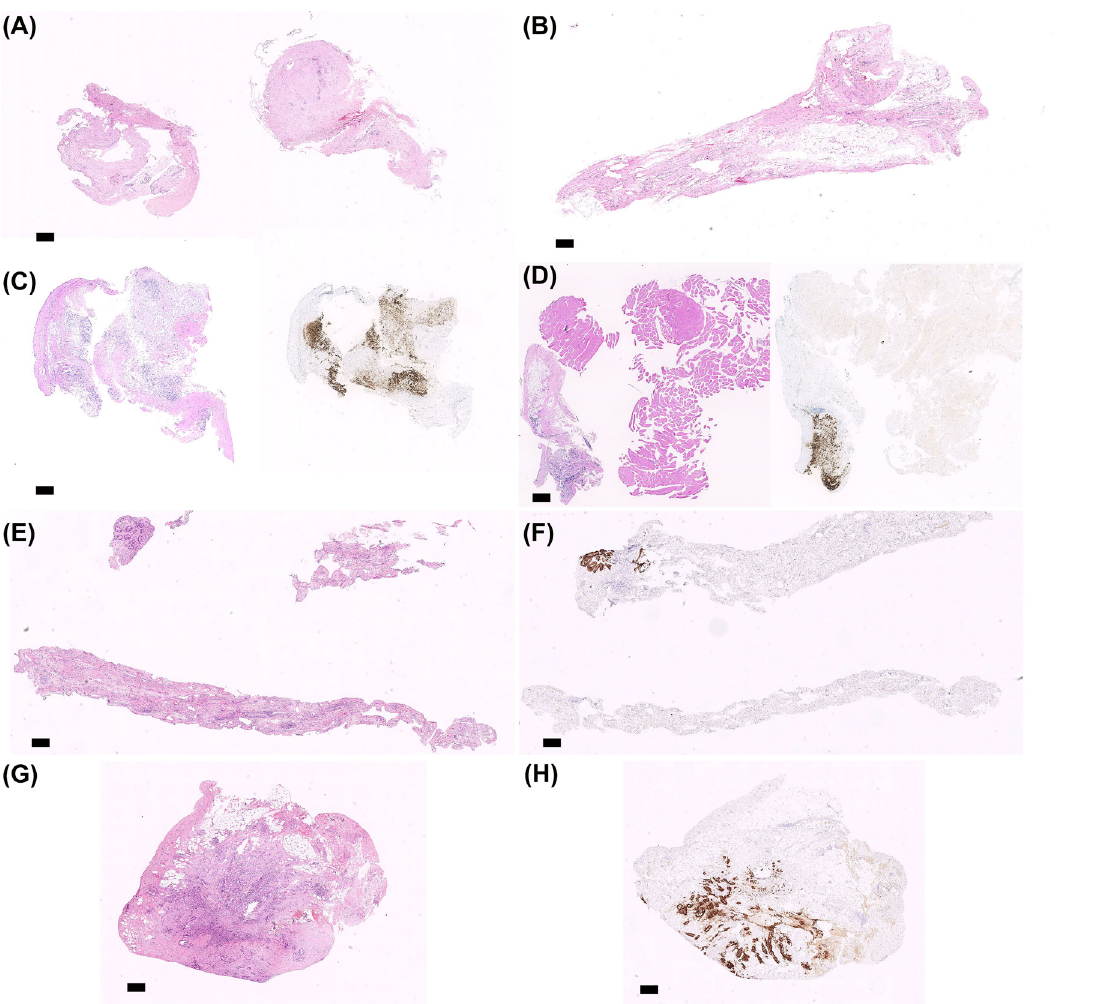
Figure2: Microscopyofperitonealbiopsiestakenafteronepressurizedintraperitonealaerosolchemotherapy(PIPAC)treatmentofperitoneal metastasis (PM). The clips marked quadrant biopsy (QB-CM) showing the maximum peritoneal regression grading score (PRGS) is shown, compared to biopsies taken from the visually most malignant features (worst biopsy, WB). (AandB)QB-CMandWBfromapatientwithPMfromgastriccancer,bothshowingcompletehistologicalresponse(PRGS1)(H&E).(CandD)WB and QB-CM from a patient with PM from colorectal cancer (left: H&E, right: EpCAM immunostaining). WB (C) shows a higher PRGS (score 4) comparedtoQB-CM(D)(score3).NotethatthemajorityoftheQB-CM(C)consistsofnormalstriatedmuscleandisthereforeexcludedfromthe PRGS assessment. (E and F) WB and (G and H) QG-CM from a patient with PM from pancreatic cancer (E and G: H&E, F and H: EpCAM immunostaining). WB (E and F) shows a lower PRGS (score 2) compared to QB-CM (G and H) (score 3). Scale bar: 0.5